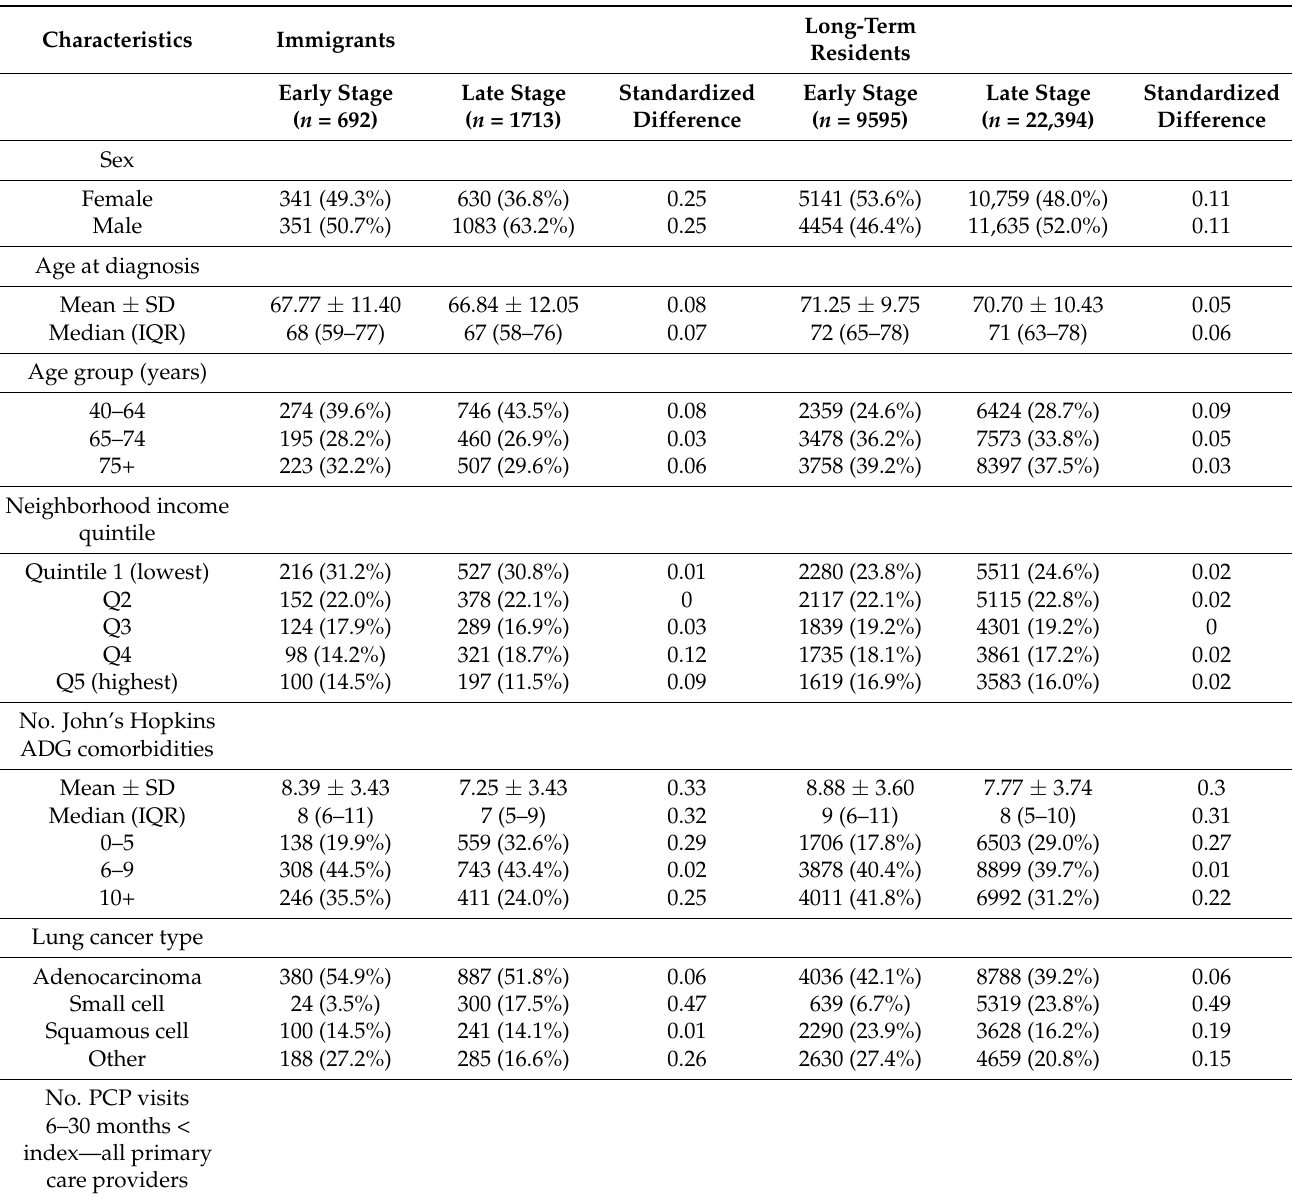
Table 2. Descriptive characteristics of study cohort stratified by stage of diagnosis (early vs. late) and immigrant status.